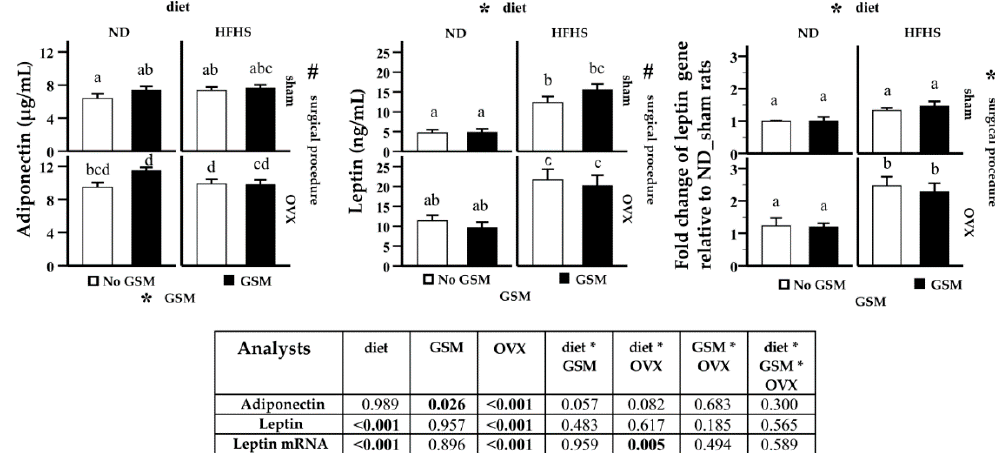
Figure 3. Analysis of plasma adipokines and leptin mRNA expression. Plasma adiponectin and leptin concentrations were measured using ELISA method ( n = 11–12 per group). The quantification of Leptin mRNA expression was performed in perigonadal fat using qRT-PCR method ( n = 7). Bar graphs and error bars show means and SE respectively. Two-way ANOVA was used to evaluate the influence of e ff ects; diet, surgical procedure and GSM. If the e ff ect was statistically significant then, the asterisk * or hash tag # was indicated. Having similar asterisk on the both e ff ects means the interaction e ff ect detected. One-way ANOVA was used to identify significant di ff erences across all groups. In case data reached the criteria, a multiple comparison test is performed using Turkey method, and then letters are indicated on the bar. Groups showing di ff erent letters are significant di ff erences. The table shows p values calculated from two-way ANOVA analysis. p < 0.05 was used to determine statistical significance in all